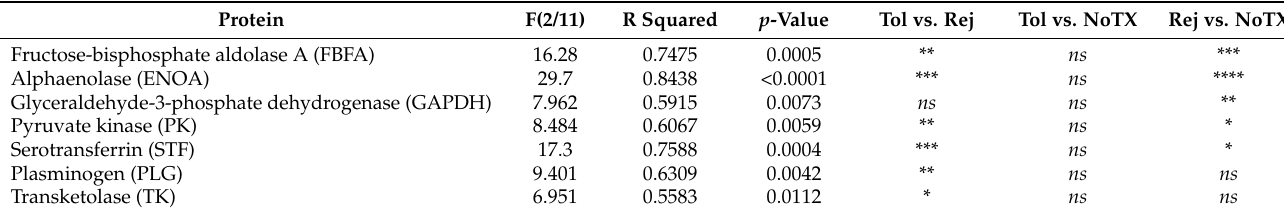
Table 2. Tuckey’s multiple comparisons for proteins related to the Warburg effect identified in the immediate local microenvironment of islet allografts under the various experimental conditions. Protein